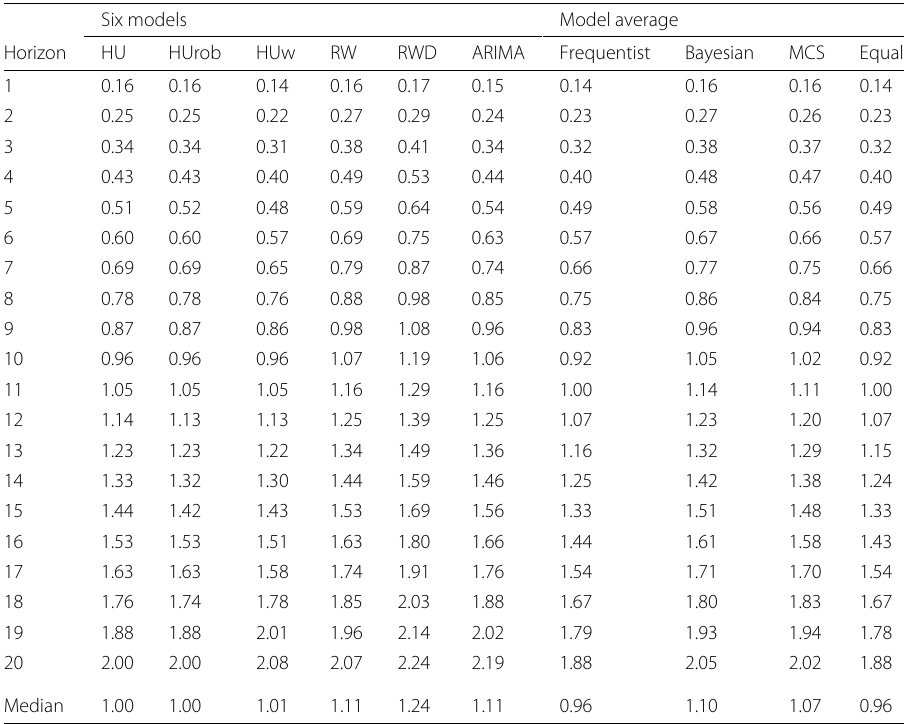
Table 2 MAFEs ( × 100) for ASFRs for 1-year-ahead to 20-year-ahead point forecasts by model/method and forecast horizon Six